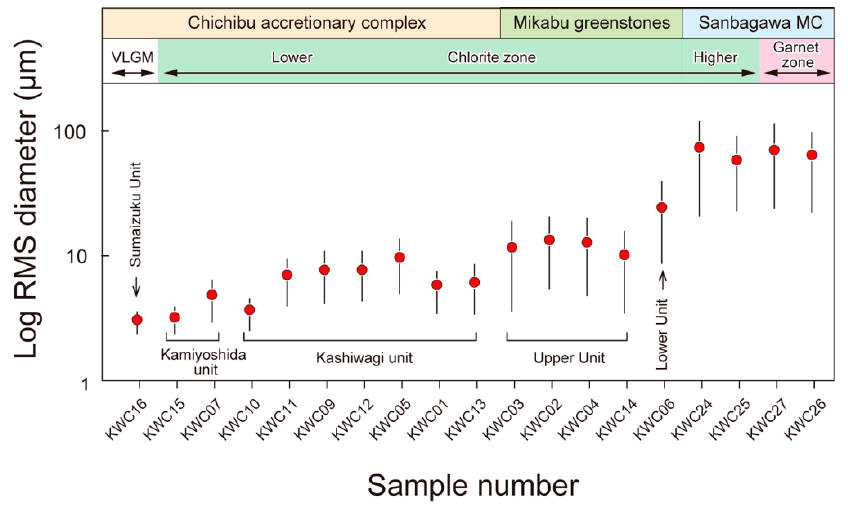
Figure 7. Distribution of the quartz diameters estimated by the RMS of the quartz grains for samples from the Chichibu accretionary complex, Mikabu greenstones, and the Sanbagawa metamorphic complex. VLGM: very low-grade metamorphism; MC: metamorphic complex.